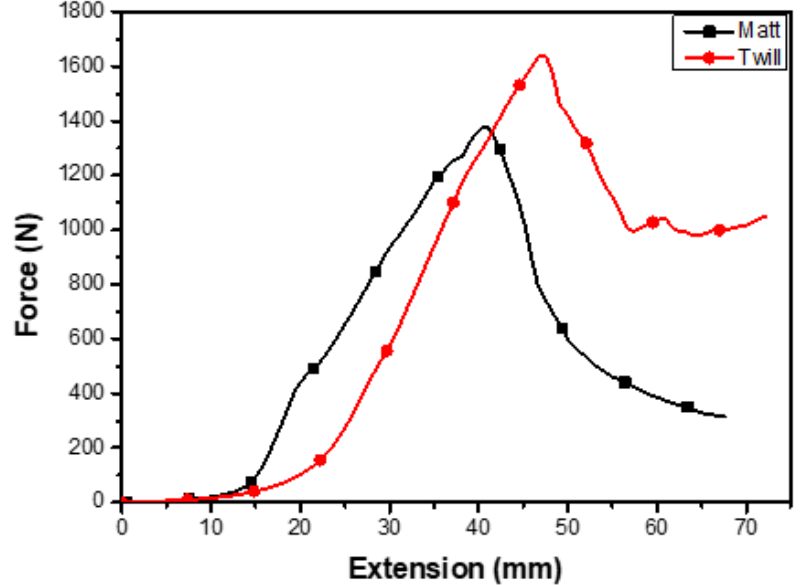
Figure 13. Puncture resistance test for twill and matt woven fabrics in warp direction.